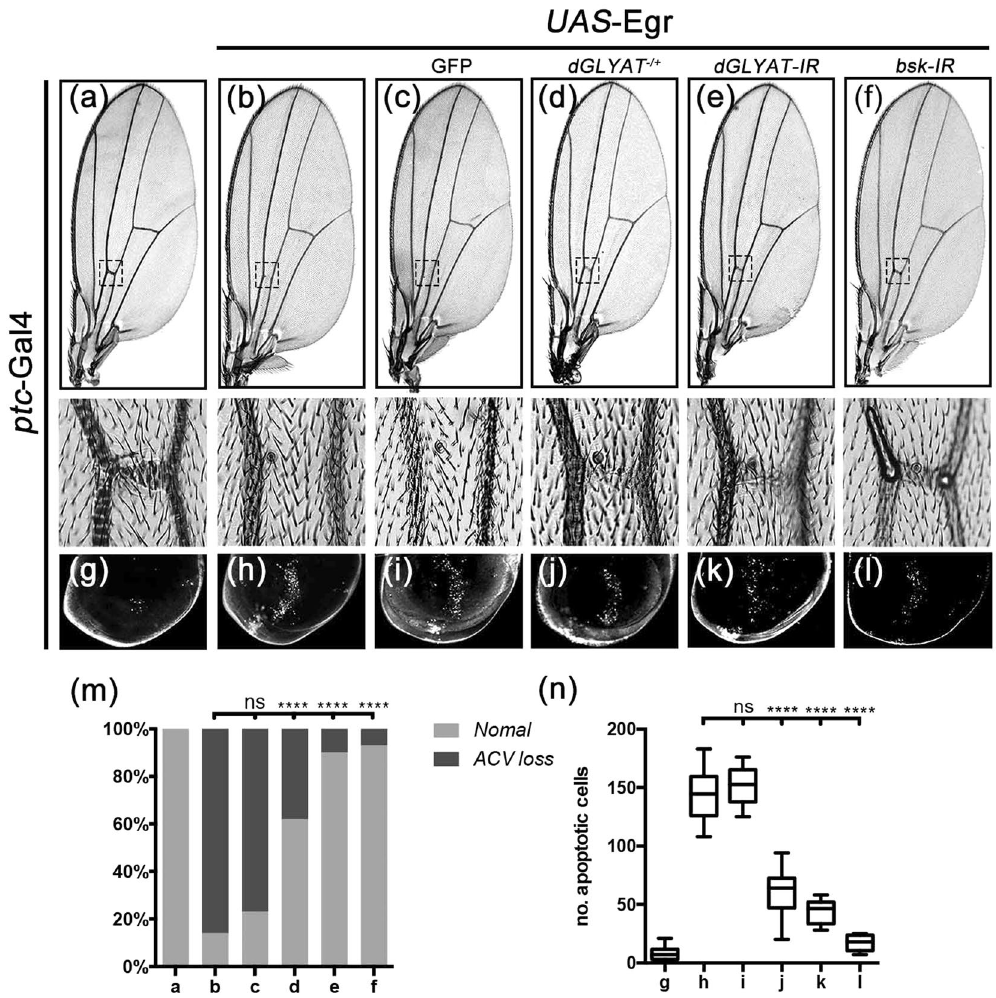
Figure 4. Loss of dGLYAT suppresses ectopic Egr-induced cell death in wing development. Light micrographs of Drosophila adult wings ( a–f ) and fluorescent micrographs of third instar wing discs ( g–l ) are shown. The lower panels are high magnification of boxed area in upper panels ( a – f ). Compared with the ptc -Gal4 controls ( a,g ), ptc > Egr induces a loss-of-ACV phenotype in adult wings ( b ) and extensive cell death along the A/P boundary in third instar larval wing discs ( h ), while remains unaffected by expressing GFP as a negative control ( c,i ). Both phenotypes are suppressed partially by mutation in dGLYAT ( d,j ) and strongly by RNAi-mediated knocking-down of dGLYAT ( e,k ). Expression of Bsk-IR acts as a positive control ( f,l ) ( m ) Statistics of the loss- of-ACV phenotype in ( a–f ) (a, n = 50; b, n = 56; c, n = 90; d, n = 88; e, n = 113; f, n = 80), (n) Statistics of the AO-positive cell number in ( g–l ) (g, n = 17; h, n = 12; i, n = 12; j, n = 21; k, n = 12; l, n = 10). n.s., P > 0.05; **** P <